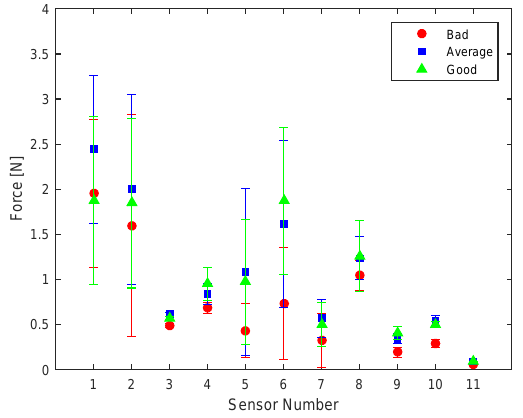
Figure 5: Average and variance of the force measured in each sensor according to the user preference (best seen in